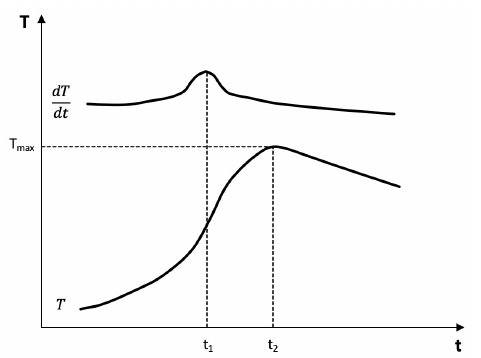
Figure 1. Schematic illustration of indirect measurement of setting time by calorimetry 12,17